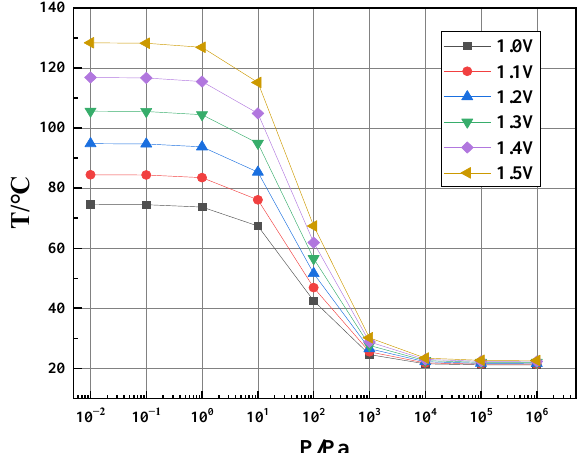
Figure 4. Simulated thermistor temperature as a function of different air pressures at different input voltages.